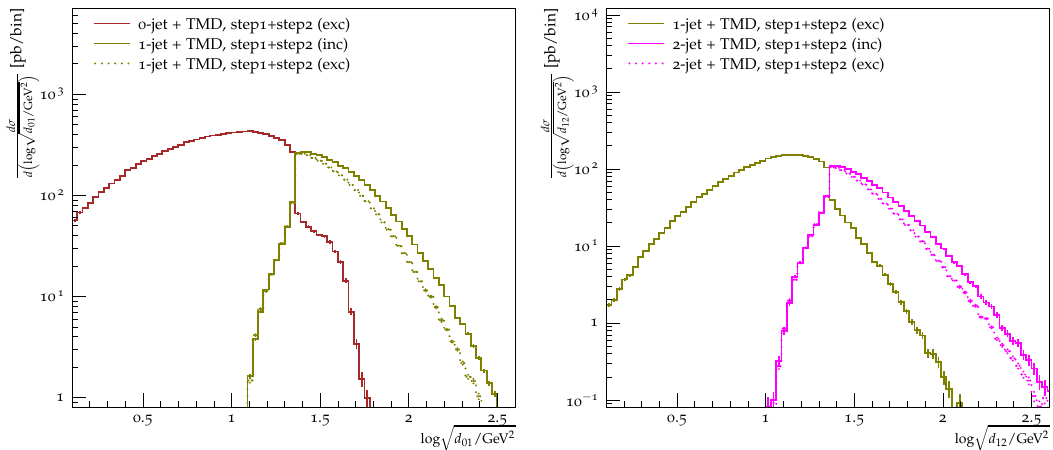
Figure 7 . The d n,n +1 spectra for n = 0 (left) and n = 1 (right) at parton level, where d n,n +1 represents the energy-square scale at which an ( n + 1) -jet event is resolved as an n -jet event in the k jet-clustering algorithm. The predictions represent the computations of the Z + 0,1 (left) and ⊥ Z + 1,2 (right) jet multiplicities when the full TMD merging method is applied (step1 + step2), where step1 corresponds to the items 1, 2, 3 and 4 of the procedure while step2 corresponds to item 5. The Z + 1 contribution to d (left) as well as the Z + 2 contribution to d (right) are calculated 01 12 in both exclusive (exc) and inclusive (inc)